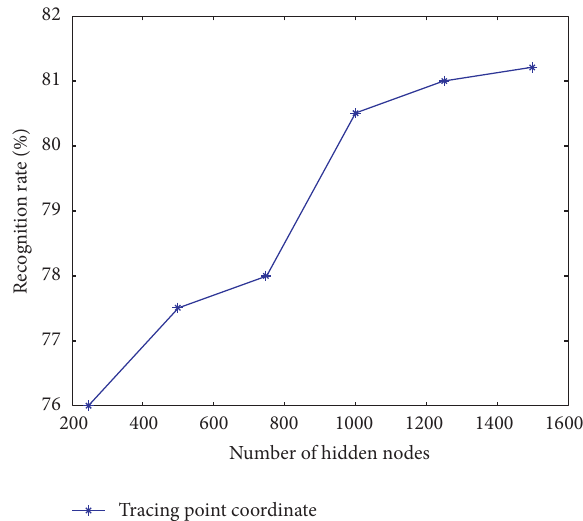
Figure 7: The influence of hidden node numbers to recognition rates Fusion